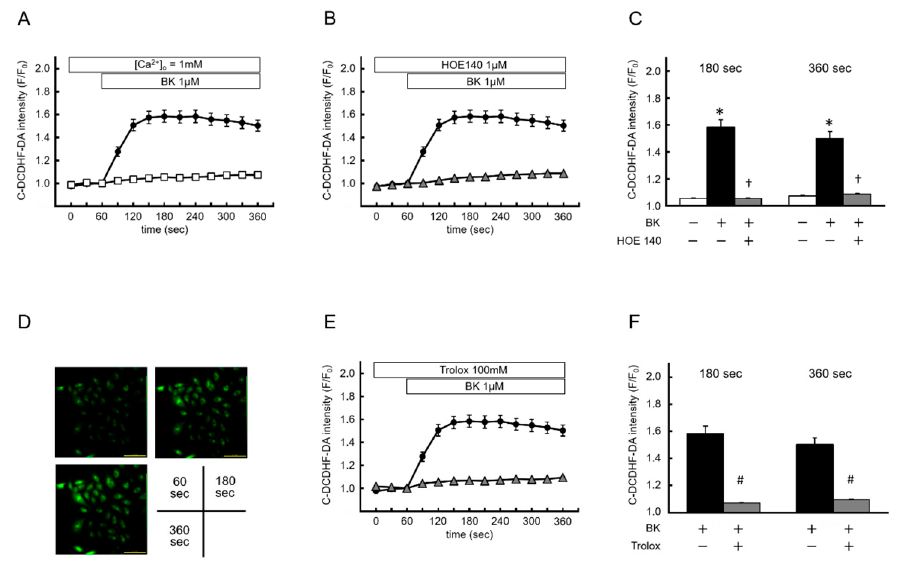
Figure 2. Bradykinin induces intracellular reactive oxygen species. ( A , B ) Time course of changes in 6-carboxy-2 ′ 7 ′ -dichlorodihydrofluorescein di-(acetate, di-acetoxymethyl ester) (C-DCDHF-DA) intensity. Porcine aortic endothelial cells were incubated with modified Tyrode’s solution (control, [Ca 2+ ] o = 1mM, open square; n = 53), and then BK was applied (closed circle; n = 111). HOE 140 (open triangle; n = 107) significantly suppressed the BK-induced increase of C-DCDHF-DA intensity. ( C ) Summarized data of C-DCDHF-DA intensity at 180 s and 360 s with or without HOE 140. ( D ) Two-dimensional images of C-DCDHF-DA 60 s (before BK application) (upper left), 180 s (upper right), and 360 s 6 (lower left). ( E , F ) The same experiments as ( A ) conducted in the presence (open triangle; n = 185) or absence (closed circle; n = 111) of trolox. Increased C-DCDHF-DA intensity reflects cytosolic reactive oxygen species production. Data are expressed as the mean ± SEM of three independent experiments in separate cell culture wells. * p < 0.01 versus control, † p < 0.01 versus BK, and # p < 0.05 versus BK. Two-factor factorial ANOVA was used for analysis of difference.